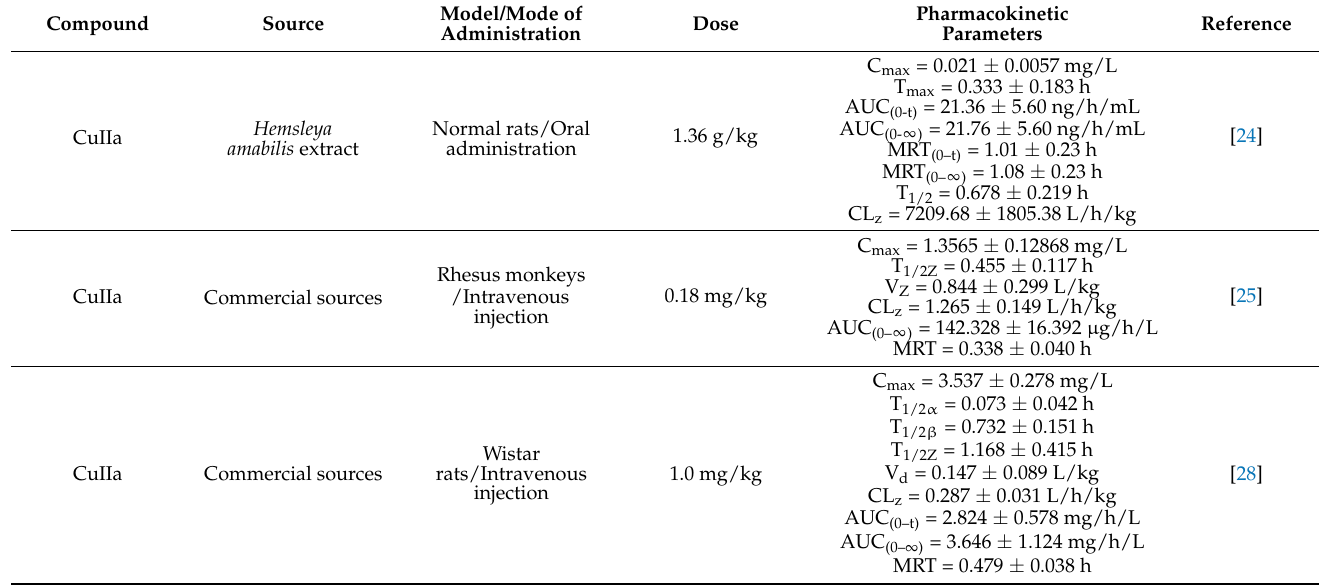
Table 1. Pharmacokinetic profiles of cucurbitacin IIa, IIb, B, and E.